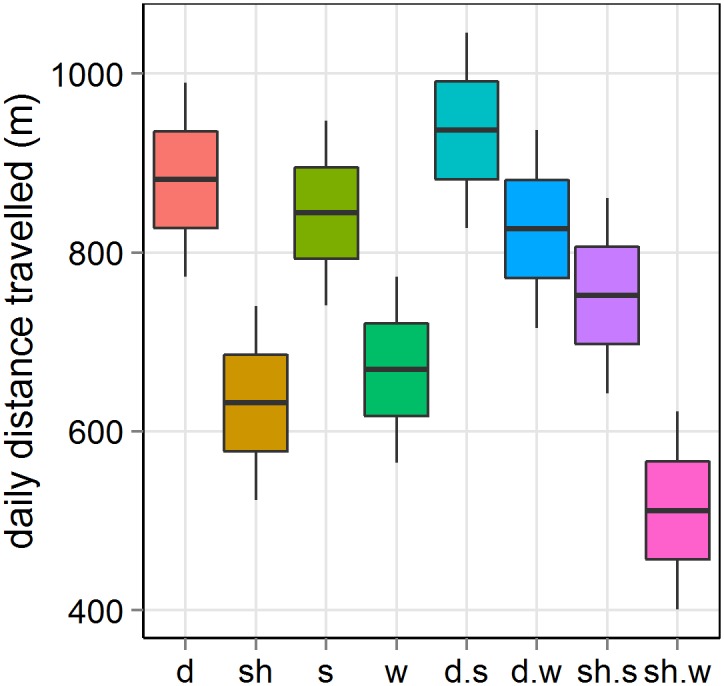
Predicted daily distance travelled by sheep (sh) and red deer (d) in summer (s) and winter (w) of the mixed linear model in Table 1.Boxes are colour coded following labels of x-axis.